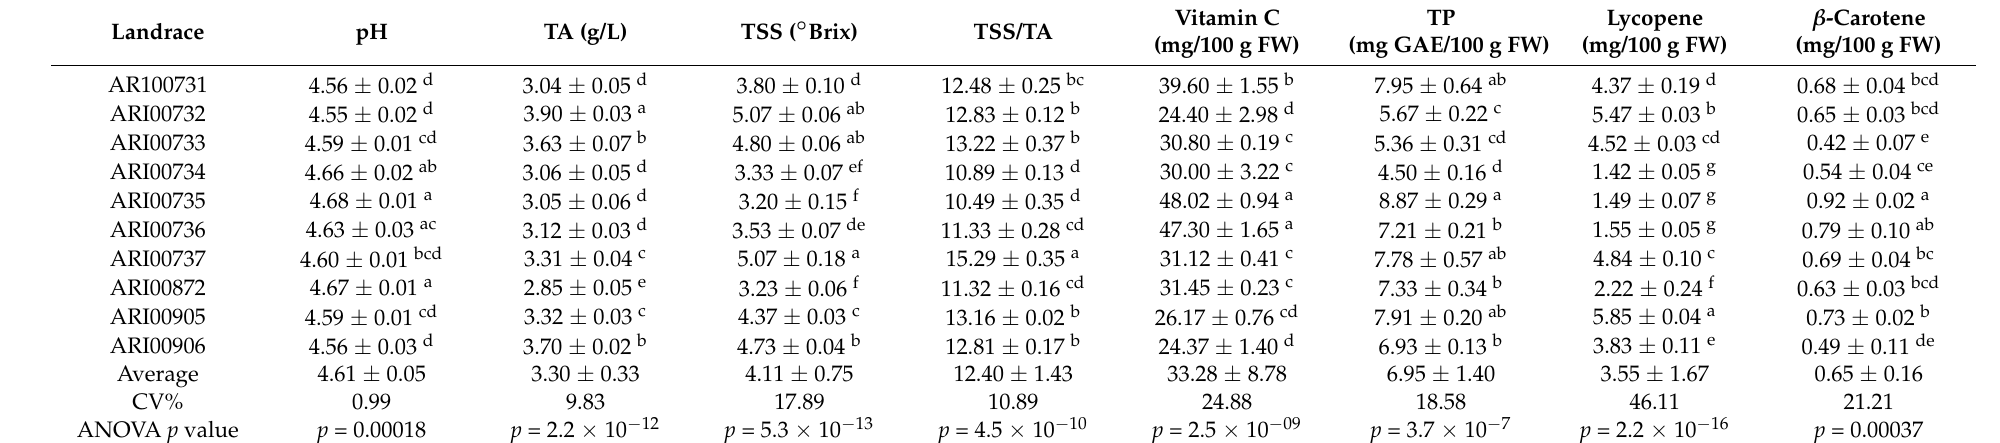
Table 5. Assessment of tomato fruit quality traits for Cypriot landraces